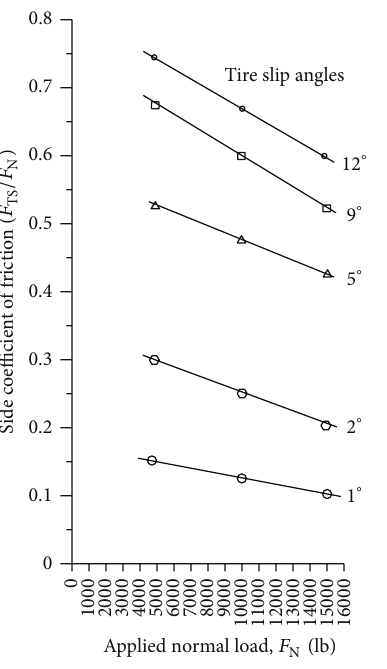
Figure 8: Side coefficient of friction results reported by the START [9] Program indicates that lateral frictional resistance to sliding in the tire contact patch decreases with increasing applied load. Table 1: Approximate values of the microhysteretic rubber friction , generated during the Yager et al. [9] sliding, side friction force, 𝐹 Hs force tests of full-scale, rotating, and bias-ply aircraft tires at five different slip angles.